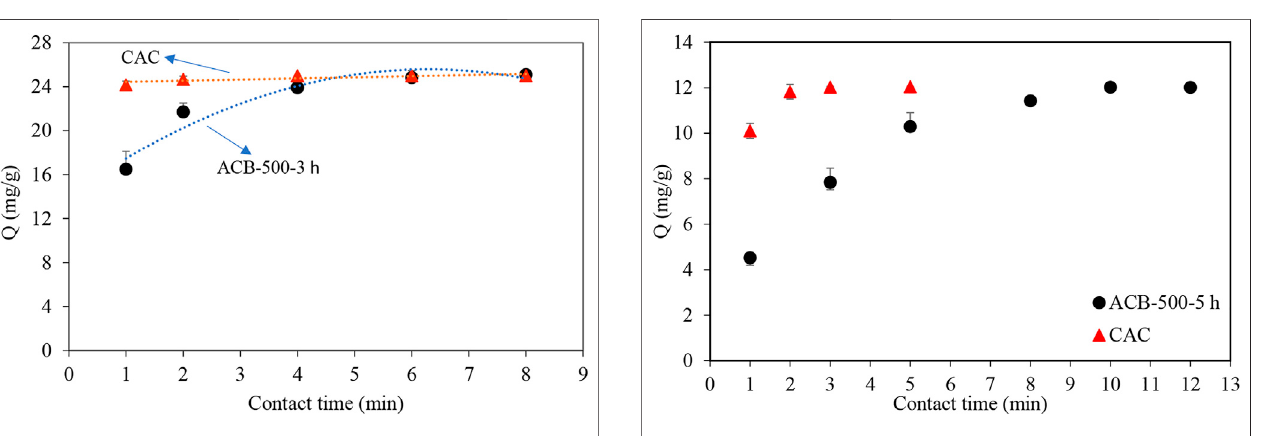
FIGURE 13 | Comparison of ibuprofen adsorption pro fi le using ACB- 500-5 h sample and commercial activated carbon (CAC). 30 ml samples with 120 mg/L of ibuprofen concentration to which 100 mg of activated bio-char and CAC was